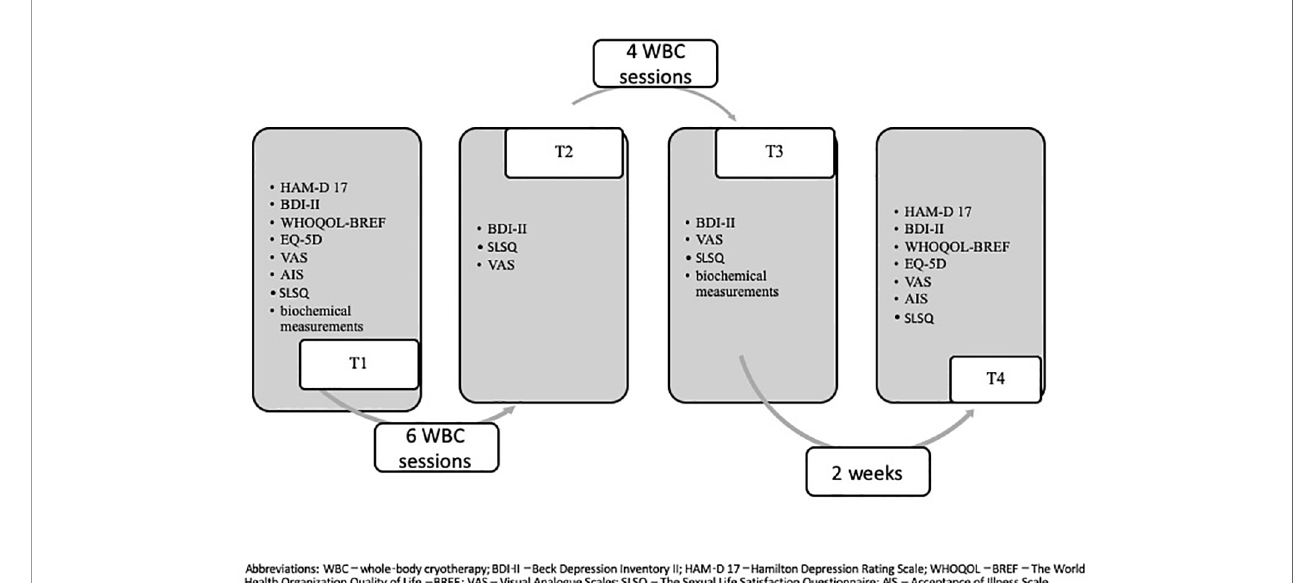
FIGURE 1 | WBC depression fl ow